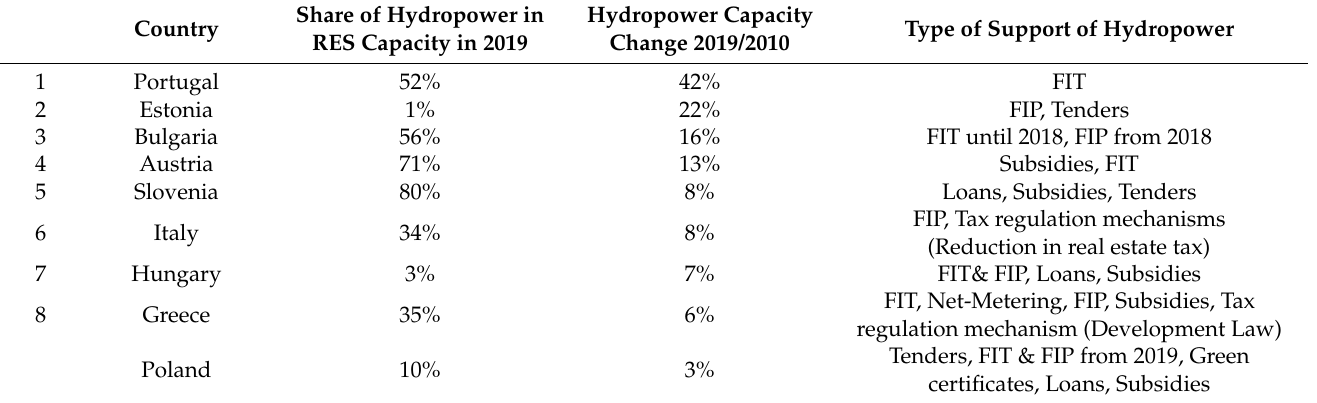
Table 2. Existing mechanisms supporting energy production in hydropower plants in EU countries where the increase in hydropower capacity is the